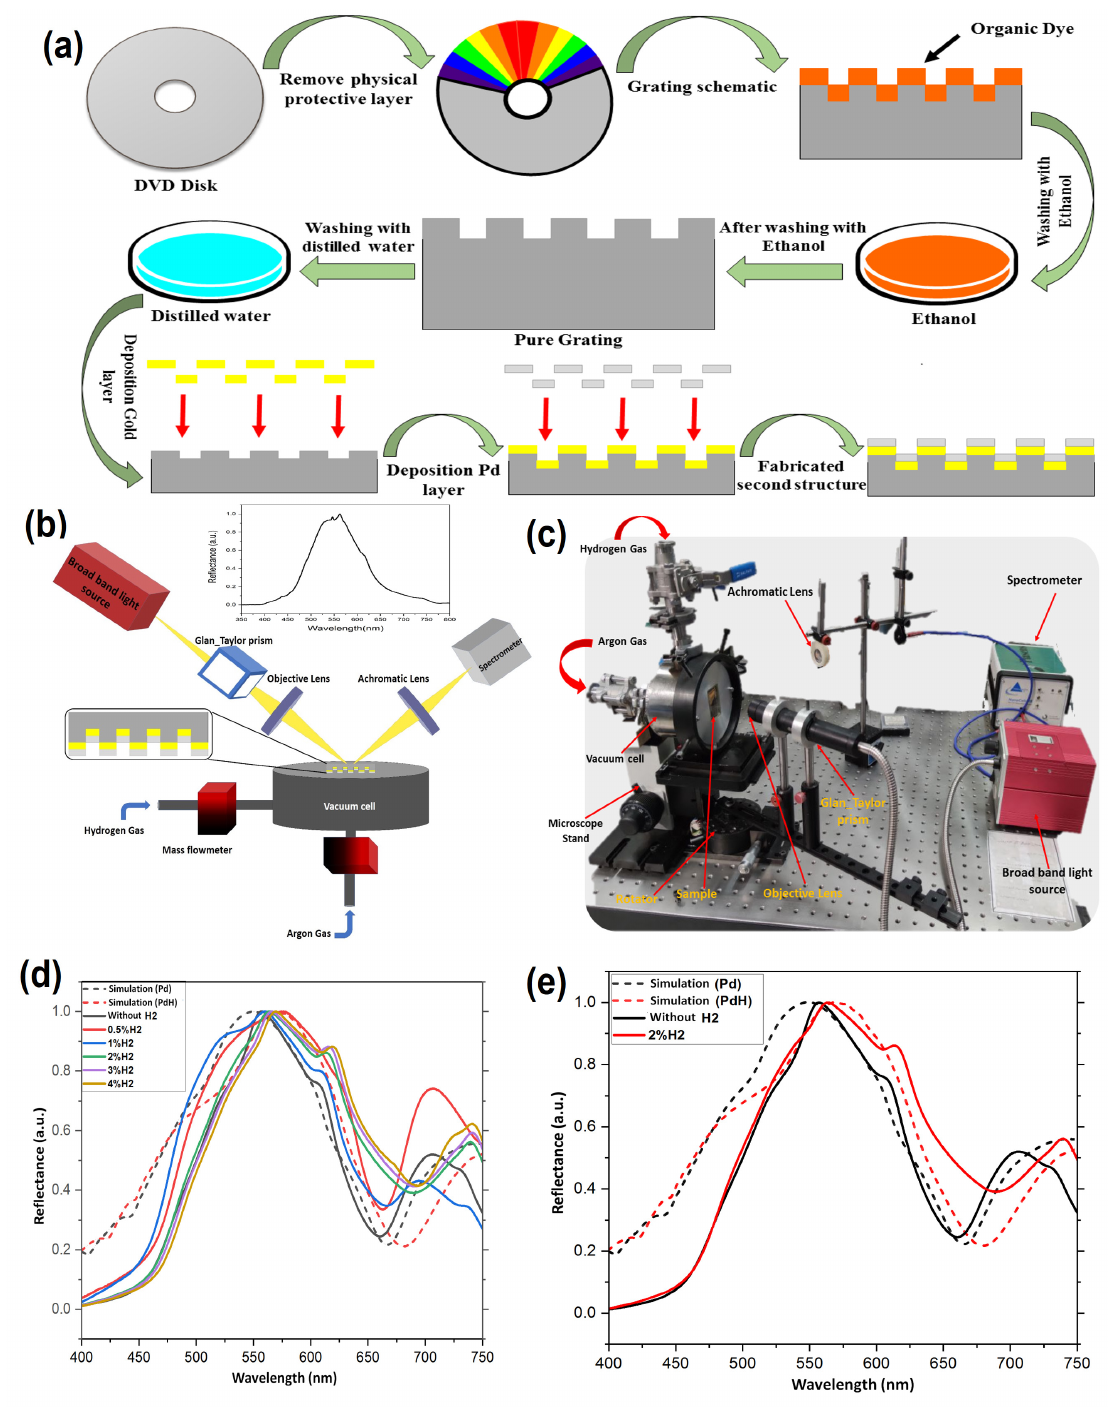
Figure 1. Fabrication, experimental configuration, and measurements. ( a ) Fabrication process of the plasmonic hydrogen gas sensor (with Au buffer layer). ( b ) Schematic of the optical setup in the vacuum chamber for reflectance measurements. The inset shows the spectrum of the broadband light source measured using the same spectrometer. ( c ) Photograph of experimental setup including indicators of the hardware components used. ( d ) FDTD simulated and experimental reflectance spectra from the nano-grating/Pd structure prototype without or with hydrogen exposure at different volumetric concentrations (0 to 4 vol.%), and ( e ) experimental and theoretical comparison of the reflectance spectra in the presence or absence of hydrogen, from the DVD-Pd nanostructure film. The incidence angle was 44 ◦